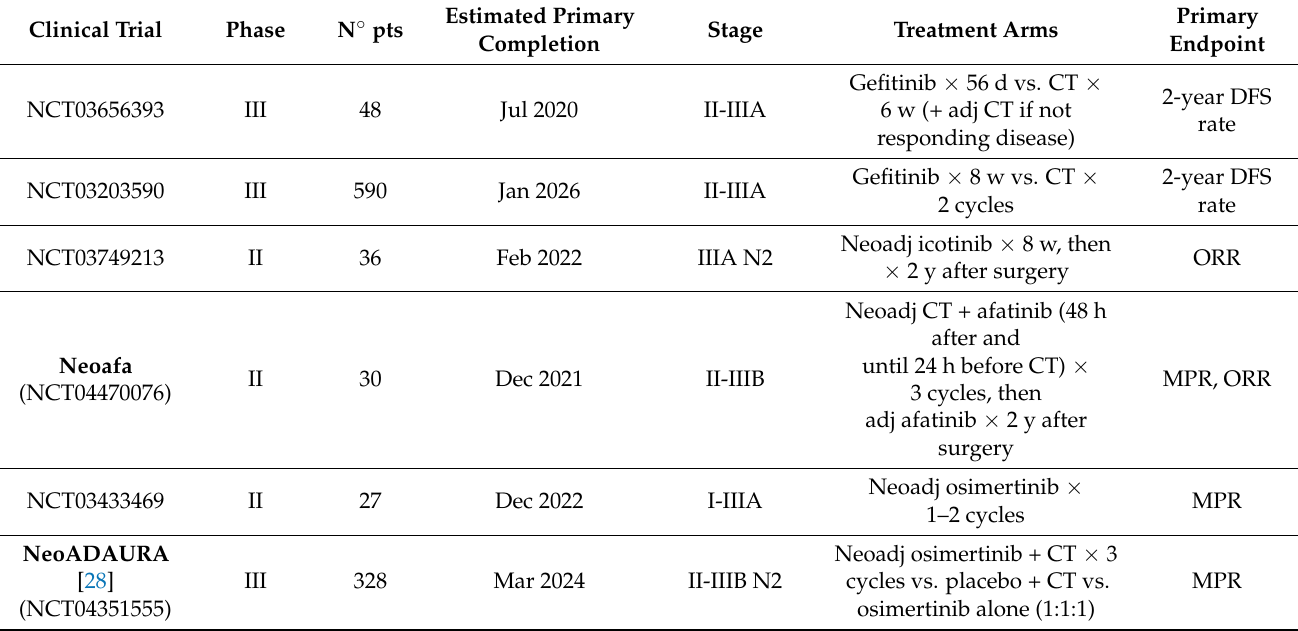
Table 3. Ongoing clinical trials with EGFR-TKIs in the neoadjuvant (+adjuvant) setting. Clinical